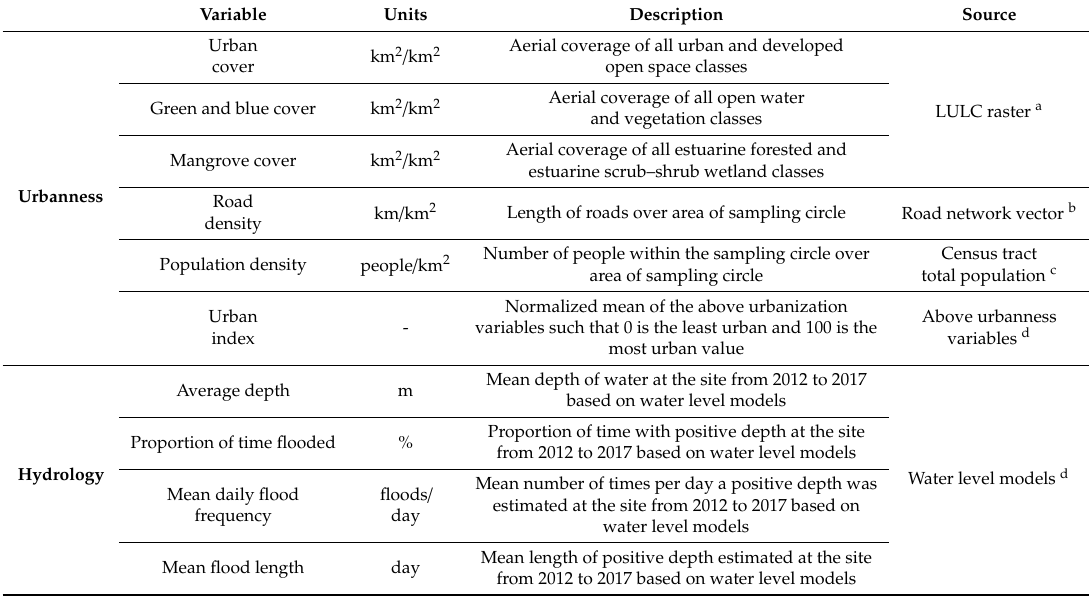
Table 3. Variables used to explain the variation in forest structure and composition metrics described in Table